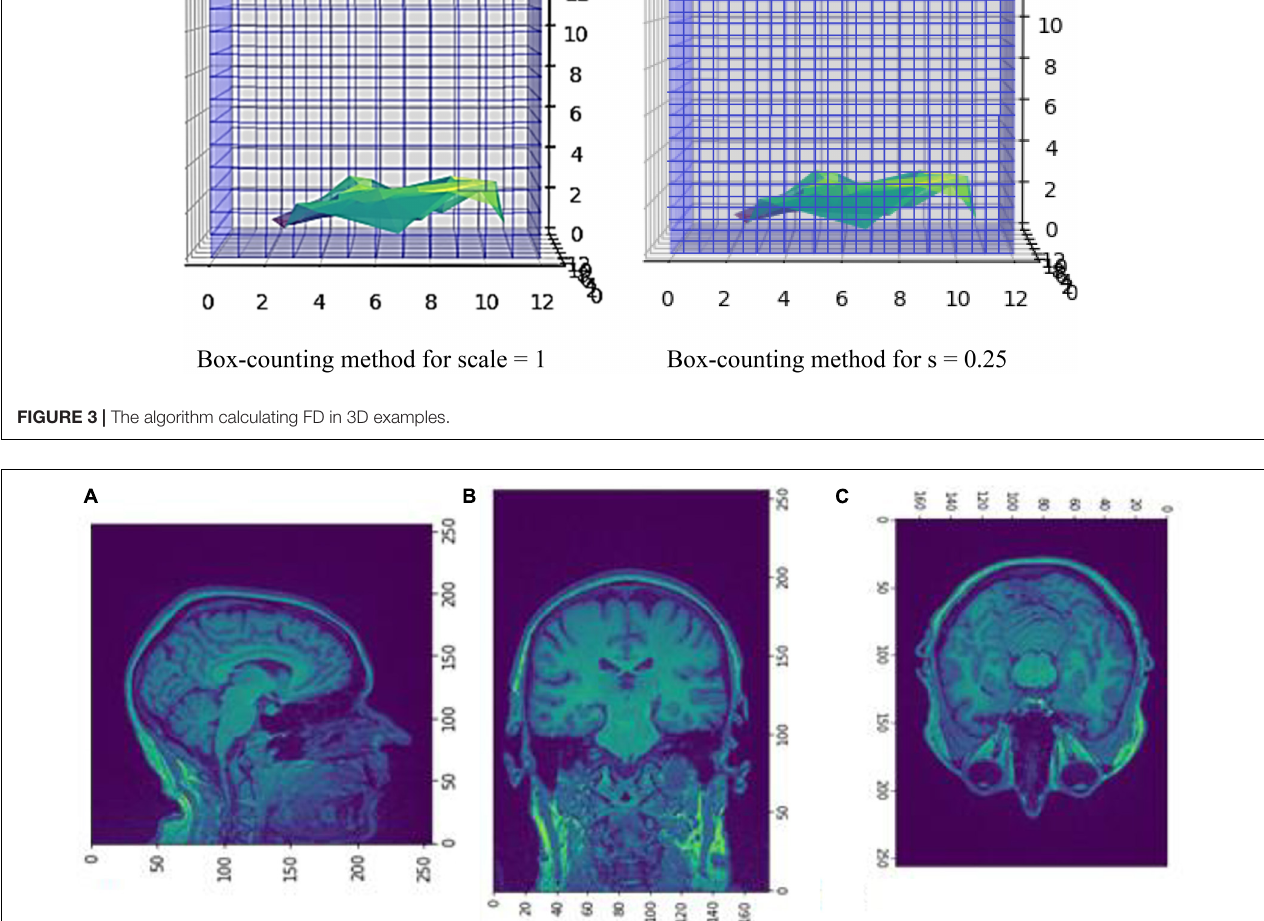
Frontiers in Aging Neuroscience |